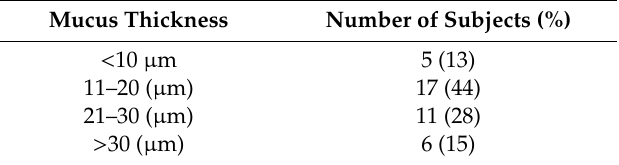
Table 3. The individual mean of the mucus thickness in 39